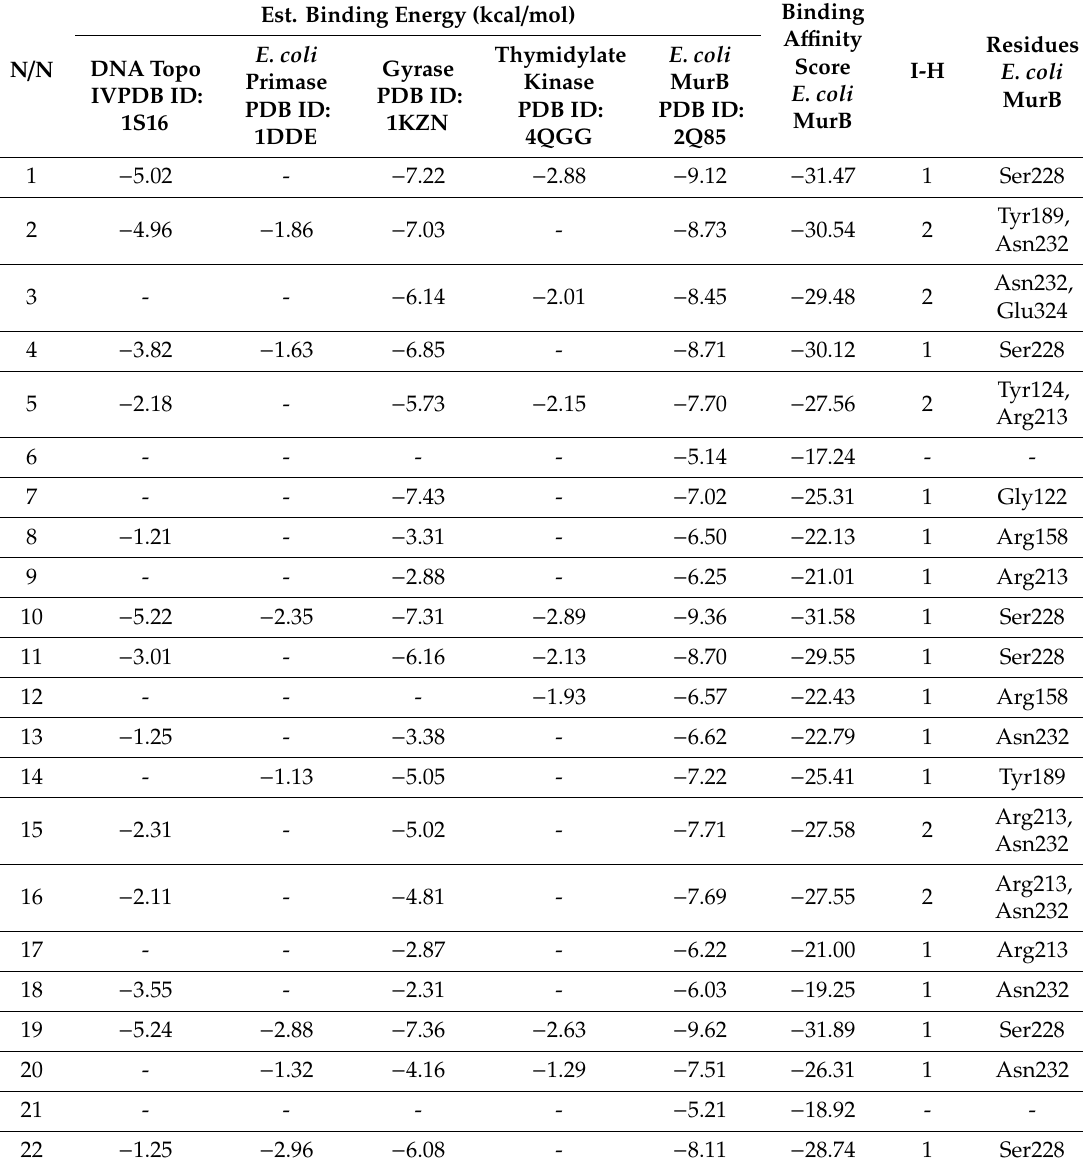
Table 5. Molecular docking binding a ffi